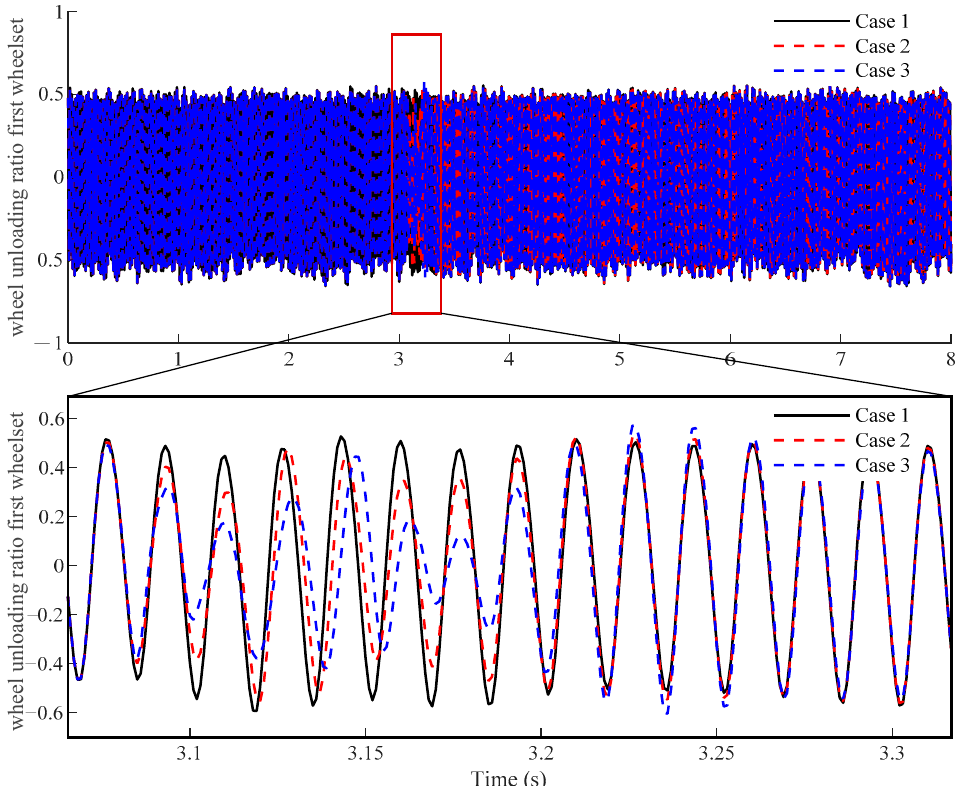
Figure 4. Time–history curve of the wheel unloading ratio.